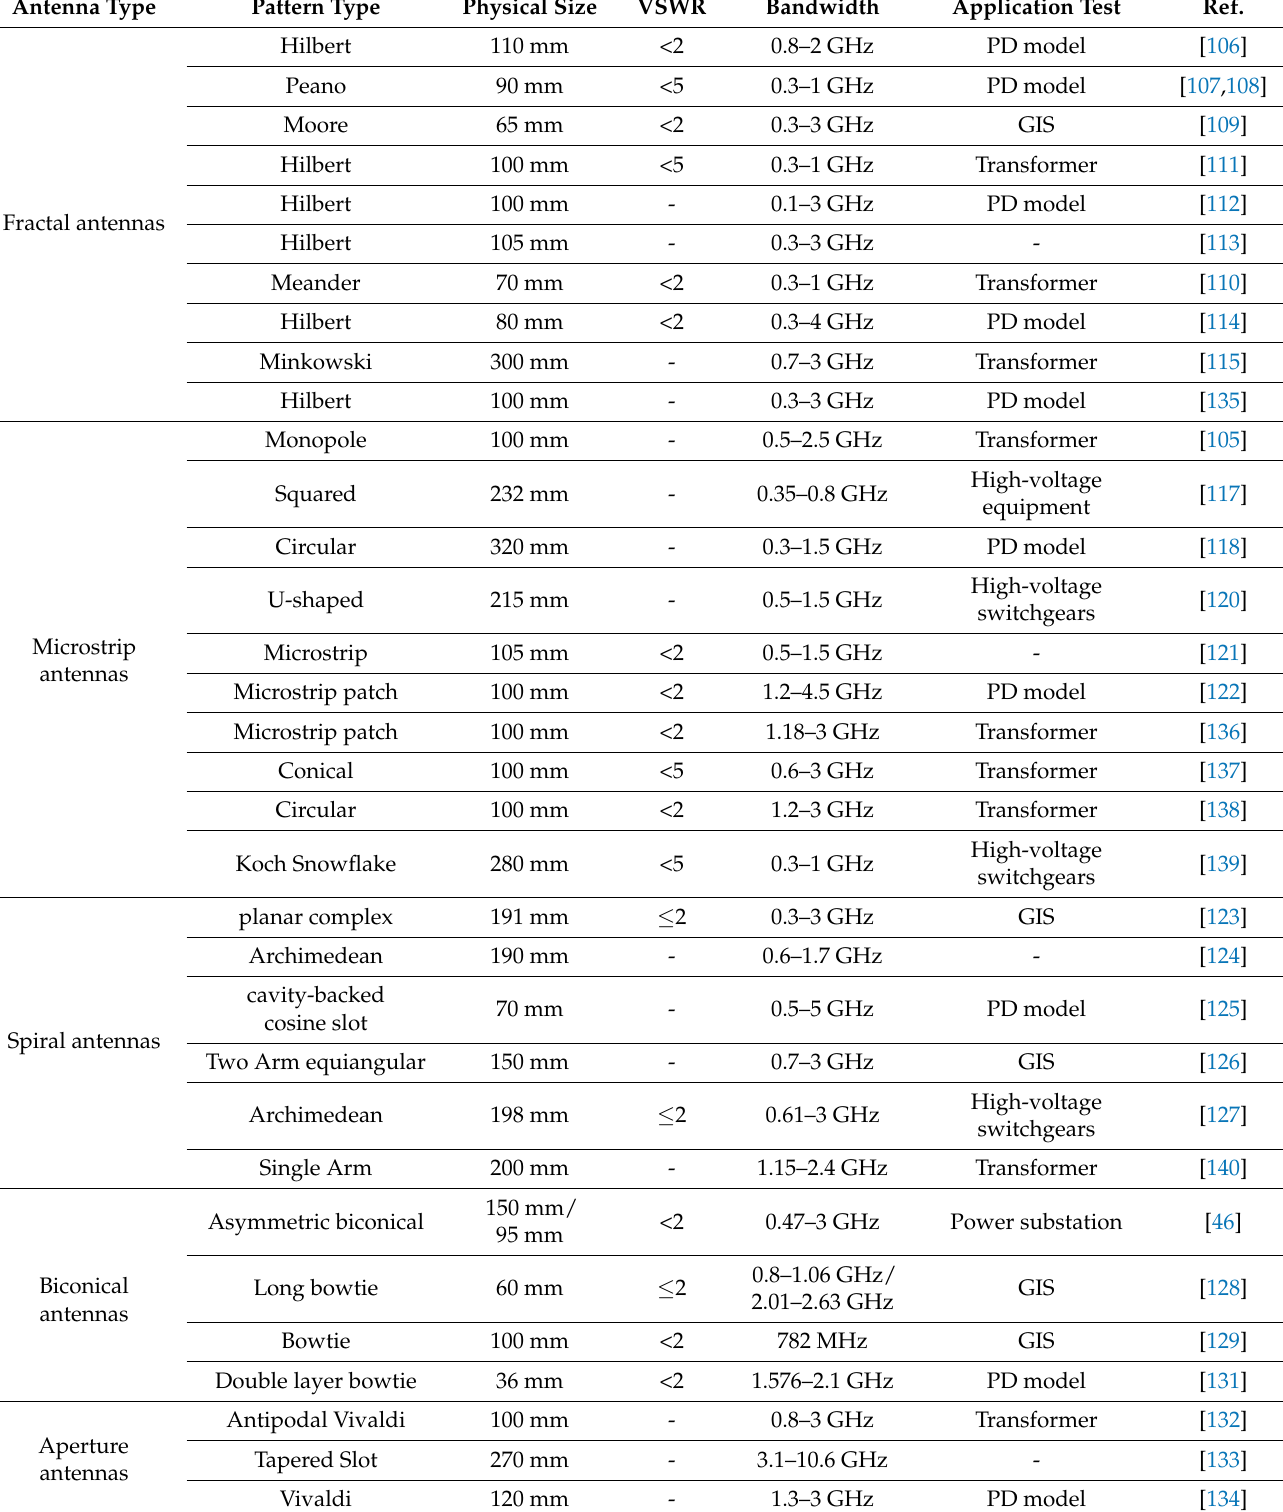
Table 2 summarizes all the UHF antennas used for PD detection described in the paper, along with their performance. Table 2. Comparison between UHF sensor designs proposed for PD